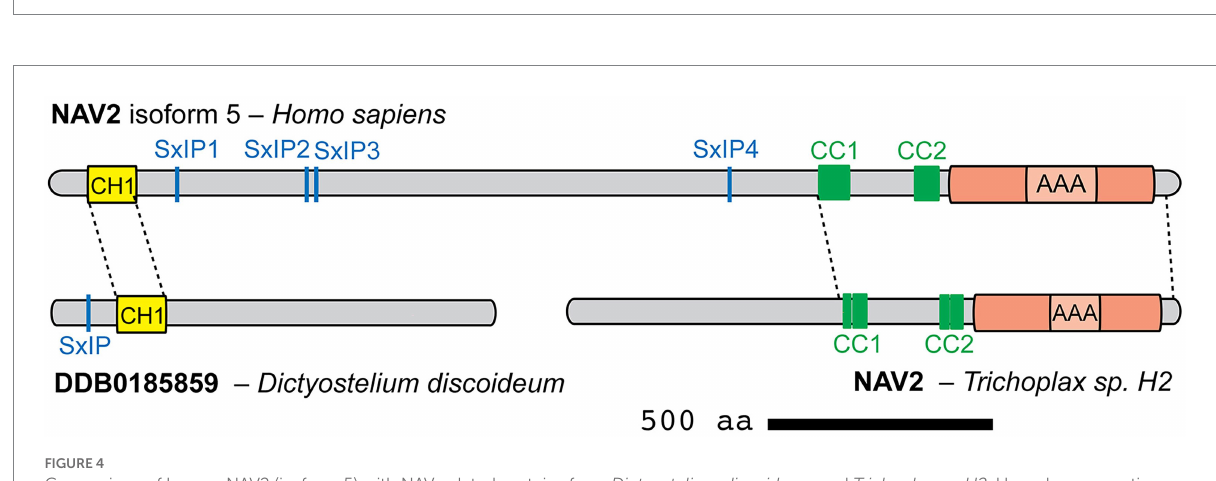
FIGURE 4 Comparison of human NAV2 (isoform 5) with NAV-related proteins from Dictyostelium discoideum and Trichoplax sp. H2 . Homologous portions of each protein are indicated by dashed lines (identified by sequence aligment using BLAST). Canonical NAVs may have arisen by fusion of a N-terminal singlet CH1 protein with a C-terminal protein containing two CC and one AAA+